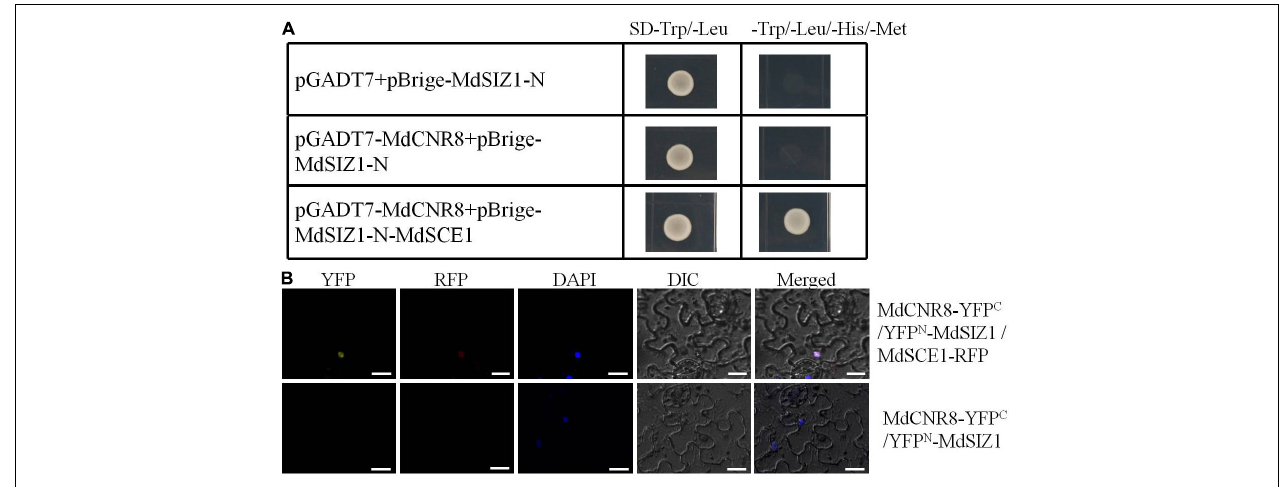
FIGURE 3 | MdCNR8 forms a complex with MdSIZ1 and MdSCE1. (A) Yeast three-hybrid assay for the interaction of MdSIZ1, MdCNR8, and MdSCE1. The MdCNR8 was cloned into pGADT7 vector (pGADT7-MdCNR8). The MdSIZ1-N and MdSCE1 were cloned into pBridge vector (pBrige-MdSIZ1-N and pBrige-MdSIZ1-N-MdSCE1). pGADT7 + pBrige-MdSIZ1-N were used as a negative control. SD, synthetically defined medium. (B) Bimolecular fluorescence complementation assays for colocalization of MdSIZ1 and MdCNR8 in the nucleus of tobacco leaves cell with the participation of MdSCE1. DAPI was used to stain the nuclei. YFP, yellow fluorescent protein; RFP, Red fluorescent protein; DIC, bright field. Bars = 20 µ m.